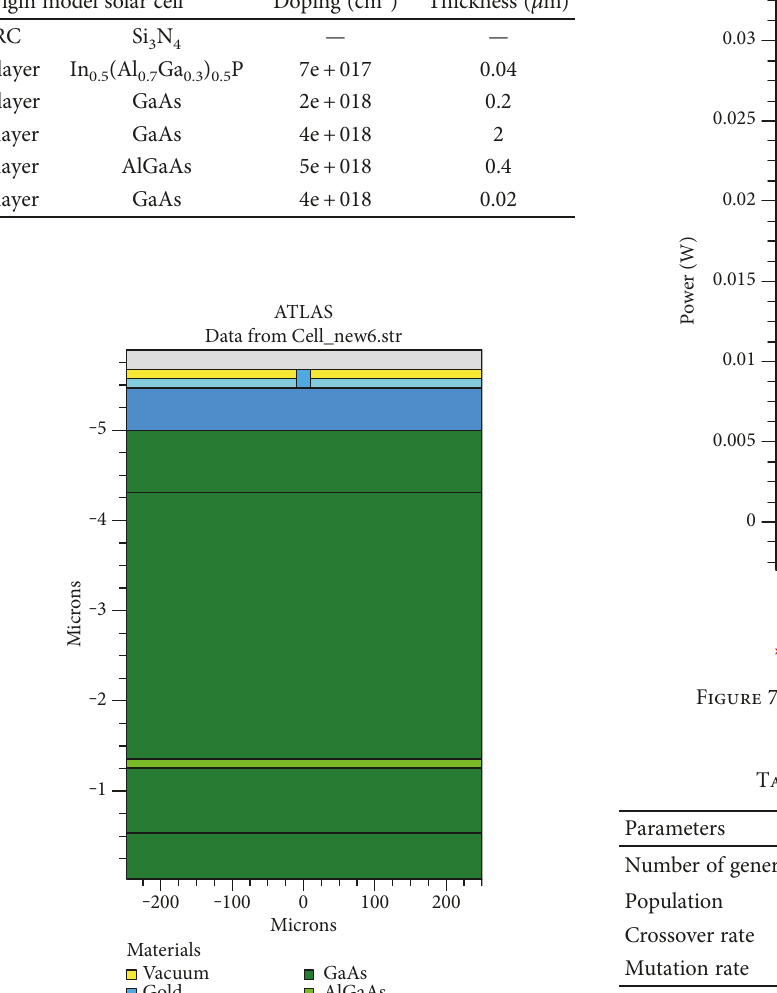
Table 2: Doping and thicknesses of the initial structure. Origin model solar